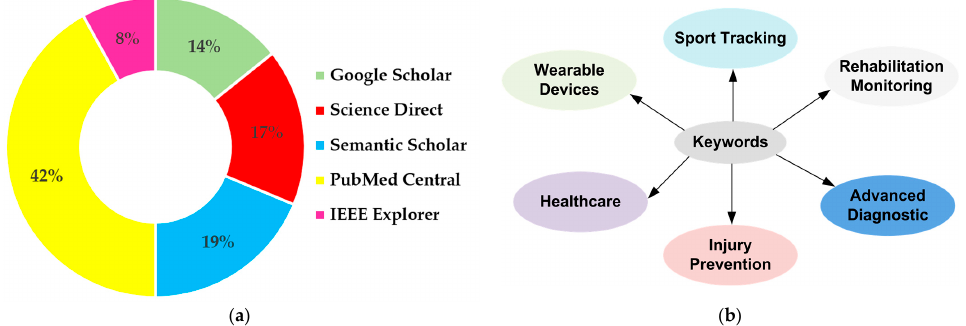
Figure 3. Distribution of the databases ( a ) and main keywords ( b ) used for searching the documents included in this review.